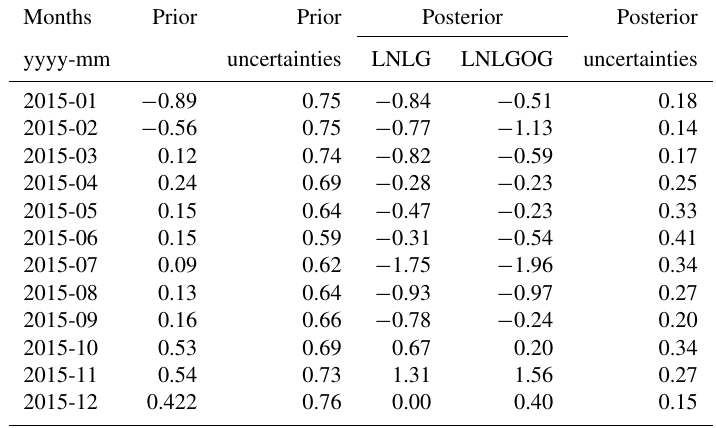
Table F1. Australia terrestrial carbon fluxes estimated using LNLG and LNLGOG for 2015 (units:PgCyr − 1 ).